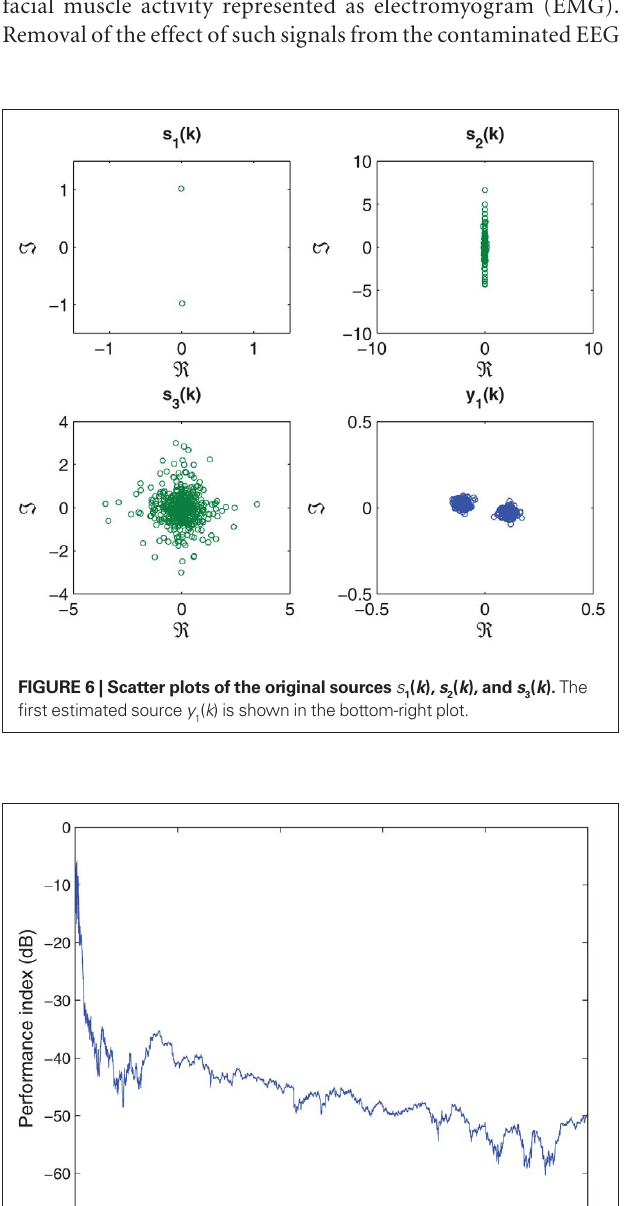
Table 2 | Source properties for noisy extraction in benchmark simulation 2.